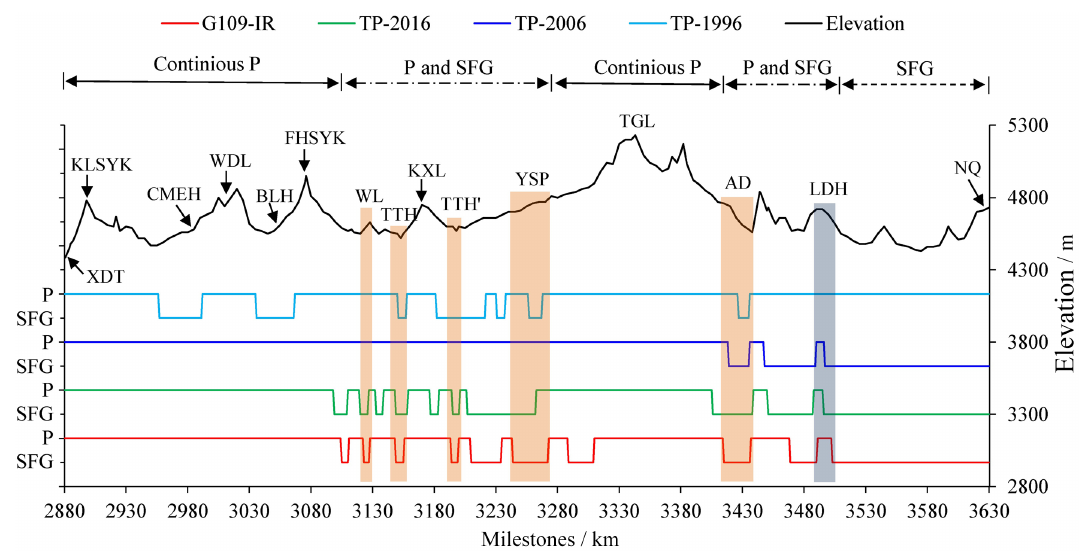
Figure 6. Comparison of permafrost distribution of three maps along the G109 transect with investigated results (P: permafrost, SFG: sea- sonally frozen ground; XDT: Xidatan, KLSYK: Kunlun Mountain Peak, WDL: Wudaoliang, BLH: Beilu River, FHSYK: Fenghuo Mountain Peak, WL: Wuli, TTH: Tuotuo River, KXL: Kaixin Mountain Ridge, TTH’: Tongtian River, YSP: Yanshiping town, TGL: Tangula Mountain Peak, AD: Anduo town, LDH: Liangdaohe, NQ: Nagqu town, G109-IR: investigated results of permafrost distribution in the G109